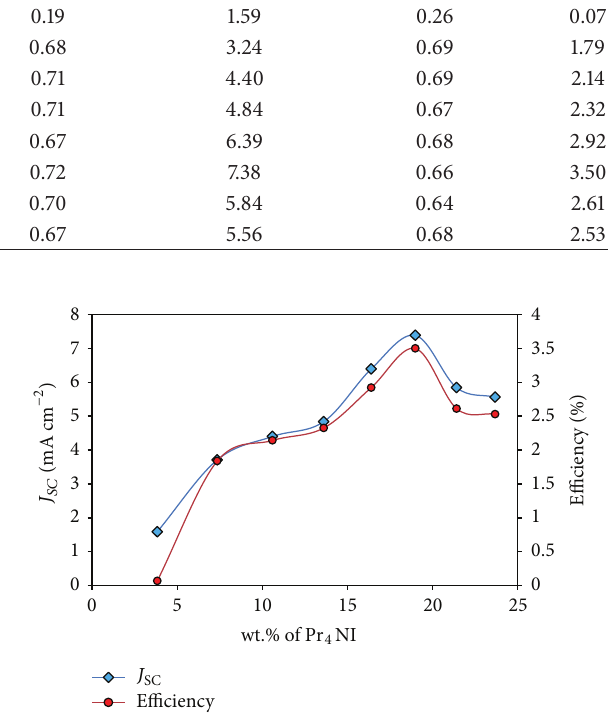
Table 3: Performance parameters of DSSCs with phthaloylchitosan-based electrolytes containing various salt contents. wt.% of Pr NI 4